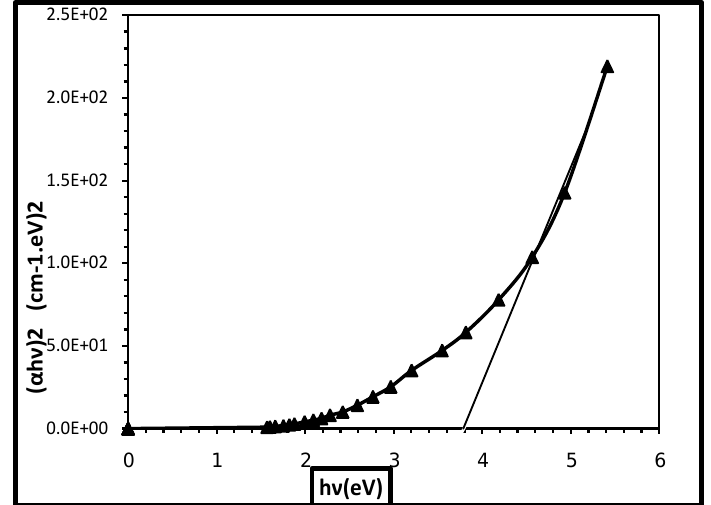
Fig.4b: (αhυ) 2 versus photon energy plot for CdTe ablated with700mj at 1064nm.